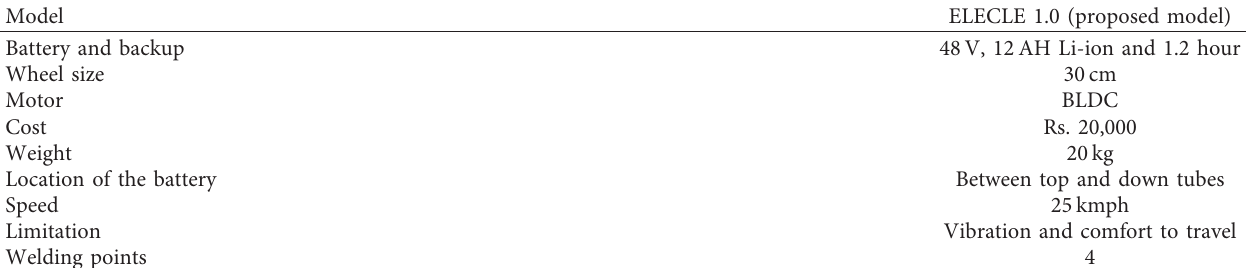
Figure 10: Prototype model of the proposed E-Bike. Table 3: Result analysis of the designed E-Bike (ELECLE